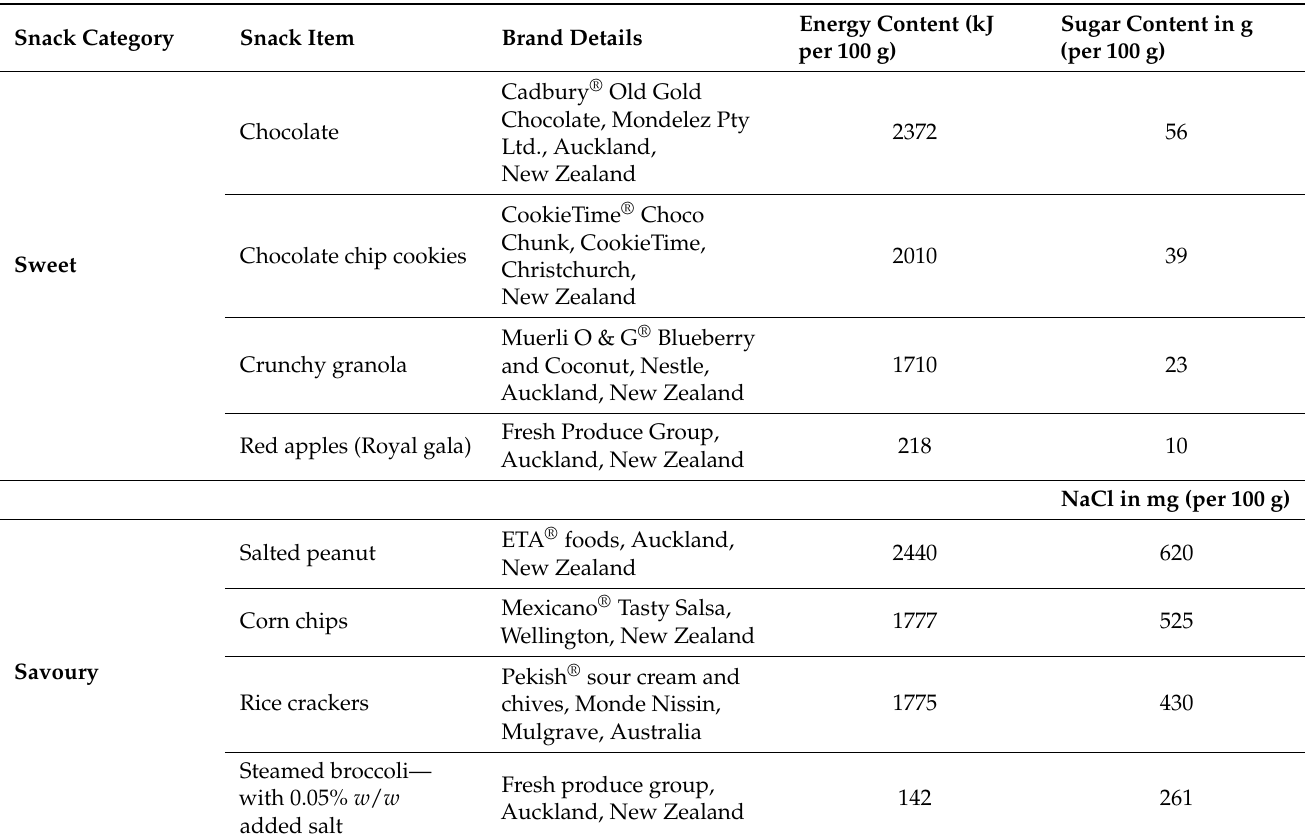
Table 2. Summary of the snack items used in the food buffet. Respective energy content (in kJ) of each snack item is reported with the sugar/salt